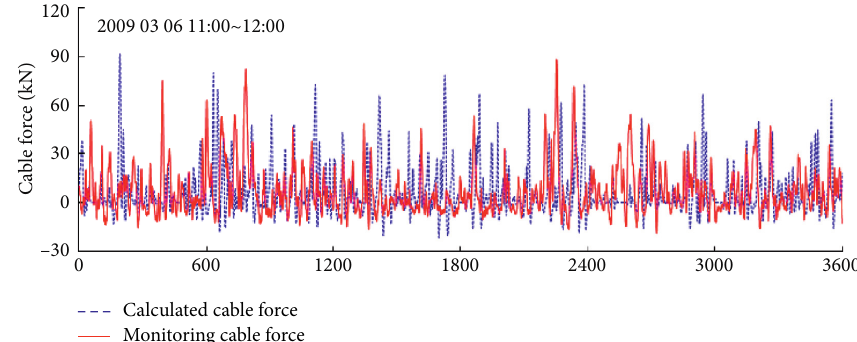
Figure 14: The comparison of simulation and monitoring